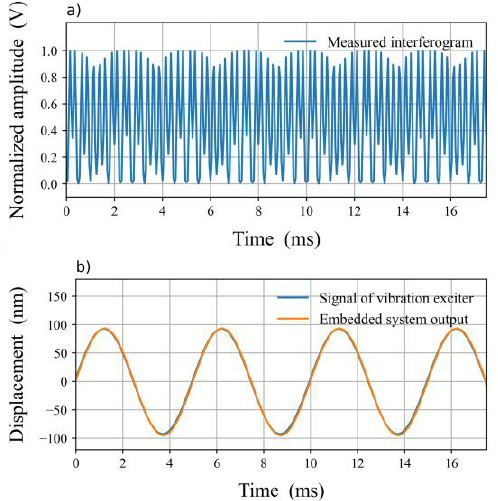
Figure 7. ( a ) Input interferogram for a modulated signal of 200 Hz. ( b ) Comparison between the modulated signal and the output signal of the embedded system, after demodulation process and scaled to λ . 4 π